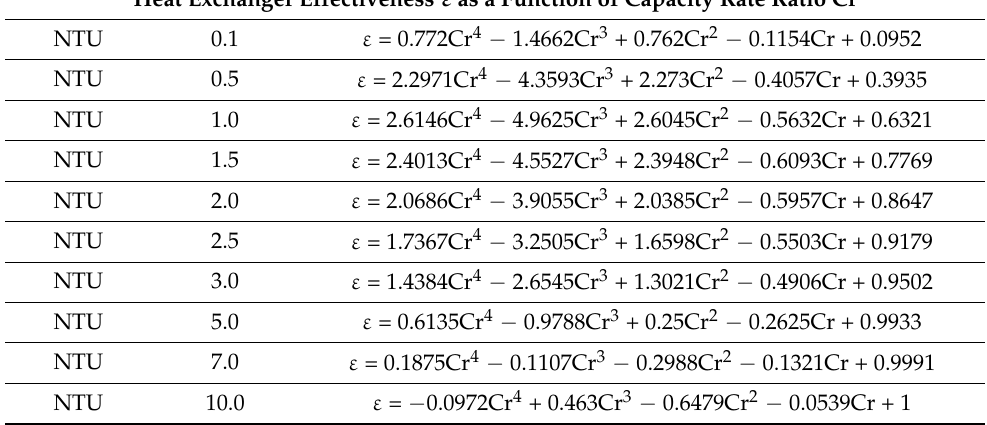
Table 4. Curve fit equations for effectiveness prediction—2-row pure cross flow heat exchanger. C min —External Fluid C max —Internal Fluid; sensible heat transfer.